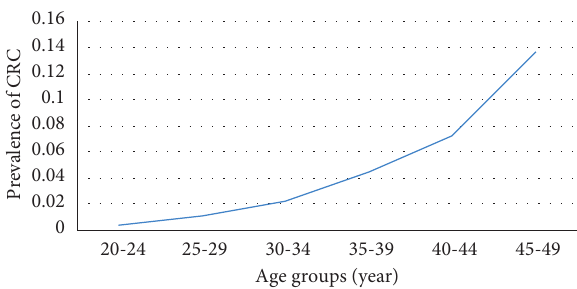
Figure 1: Prevalence of CRC in different age groups.